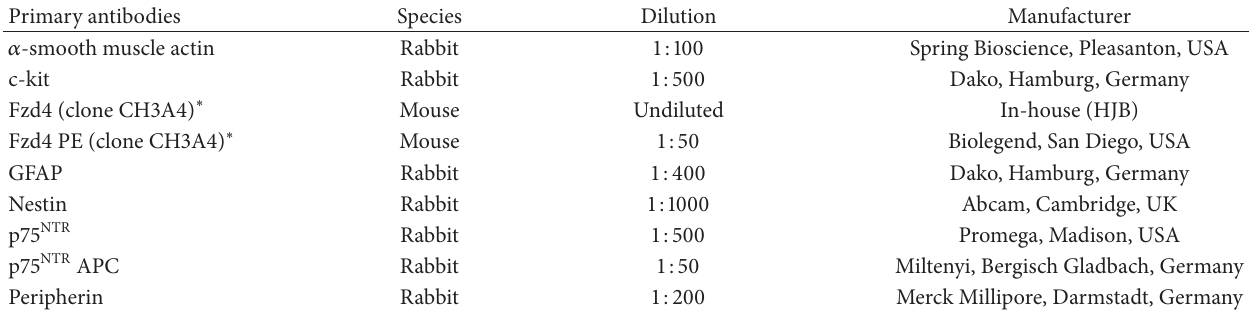
Table 2: Primary antibodies used for cell